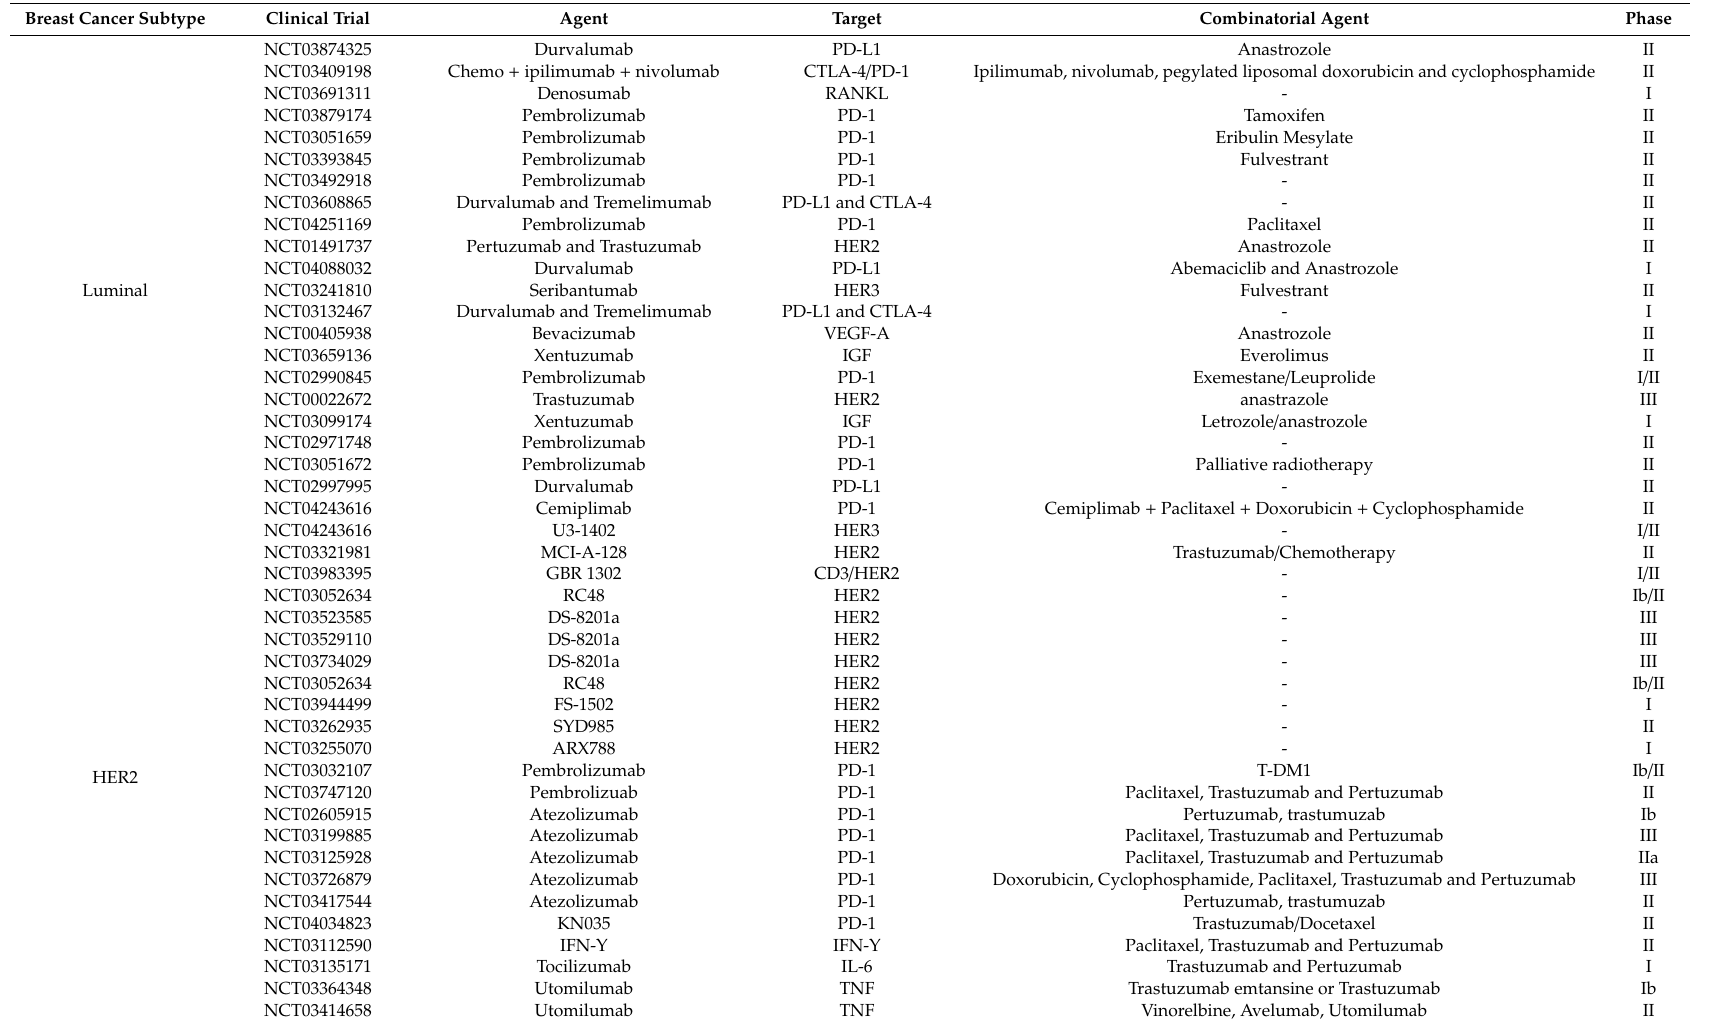
Table 2. Summary of ongoing clinical trials evaluating ADCs (antibody drug conjugates) in breast cancer describing the target, agent and the clinical stage ent. Breast Cancer Subtype